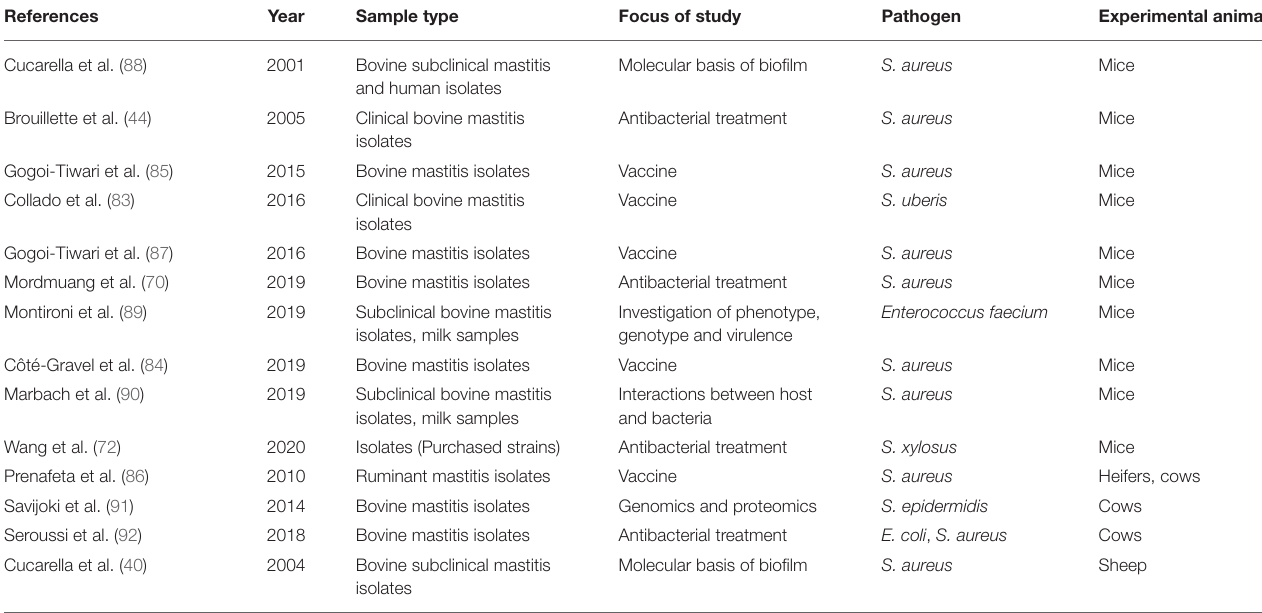
TABLE 1 | Studies investigating biofilm forming bovine mastitis pathogens in animal models or the effect of possible antibacterial agents and vaccines in animal